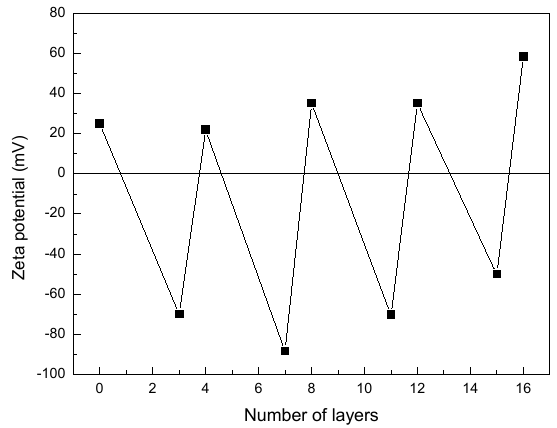
Figure 2. Variation of the zeta potential with deposited polyelectrolytes